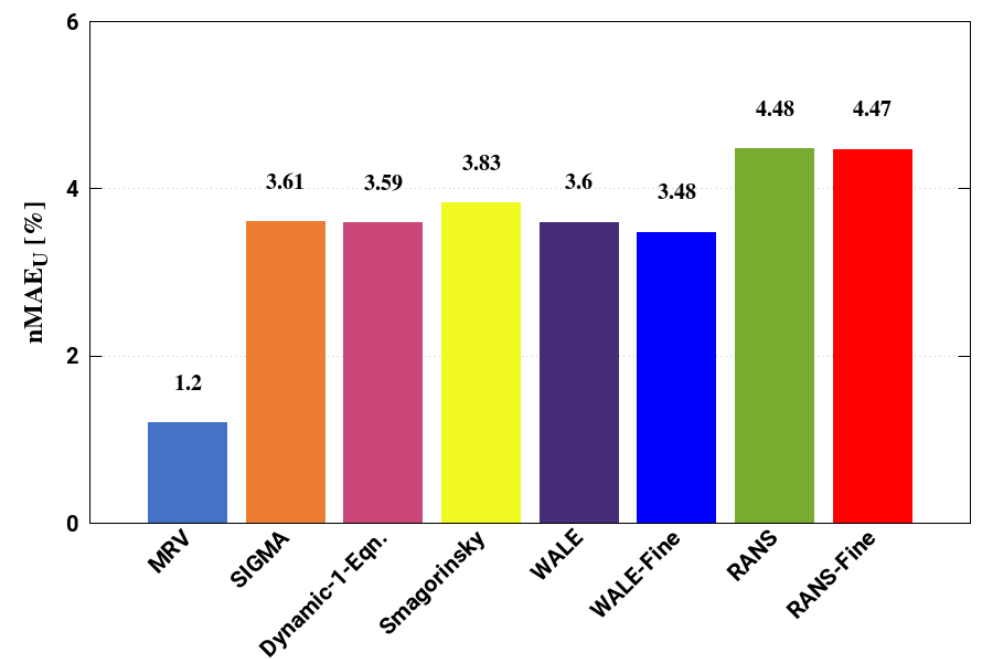
Figure 5. Comparison of normalized mean absolute error (nMAE) of velocity against MRV(Magnetic resonance velocimetry) data for various turbulence